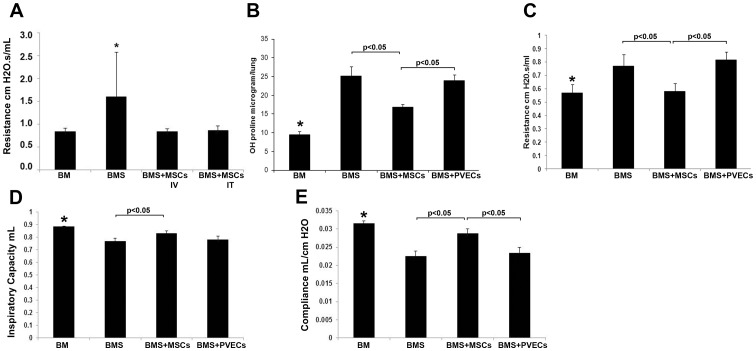
Early administration of MSC reduces post BMT manifestations of OB.Starting at 2 weeks post-BMT, MSCs or PVECs were administered IV or IT weekly and evaluated on day 90 post-BMT. A. Interim analysis at day 60 post-BMT shows equivalent efficacy of MSCs administered by either the IV or IT route as assessed by improved (reduced) airway resistance. N = 4–6/group, *p = 0.03 vs all other groups. B. Day 90 post-BMT hydroxyproline levels indicating degree of fibrosis is significantly reduced by administration of MSCs. *p<0.05 vs all other groups; other significant differences indicated on graph. N = 4–7/group, IV and IT combined) C, D, E. Improved day 90 post-BMT airway resistance, inspiratory capacity and compliance, respectively, by administration of MSCs. *p<0.05 vs BMS and BMS+PVECs; other significant differences indicated on graph. N = 4–7/group, IV and IT combined. PVECs = pulmonary vein endothelial cells used as control cells. All data are pooled from 2 experiments.